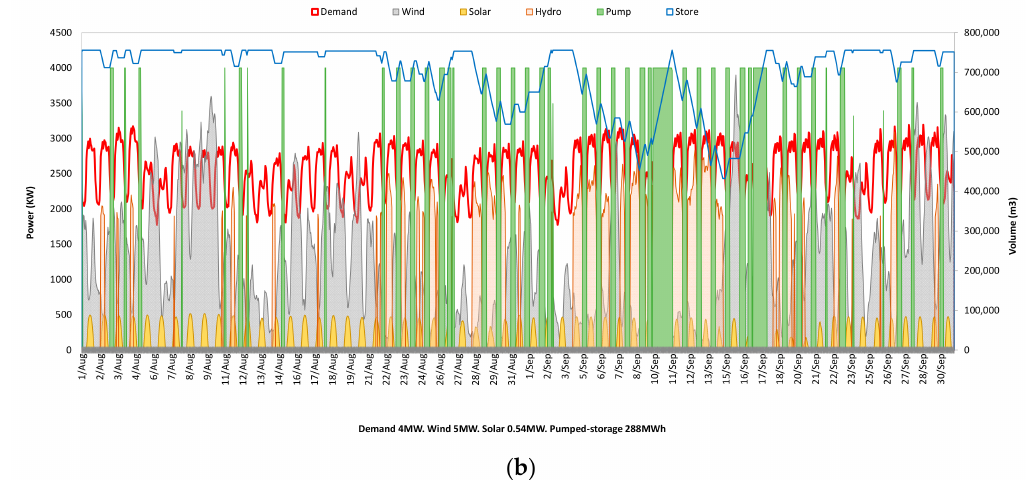
Figure 12. Electricity generation and stored in scenario 3, between February and March ( a ) and August and September ( b ).